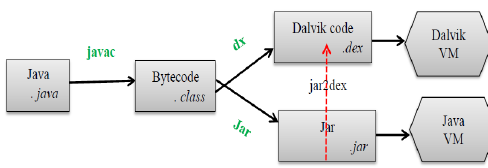
Figure 10 . Compatibility of OSGi with